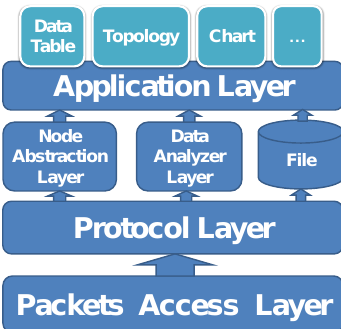
Figure 7: The model of the data storage technique in